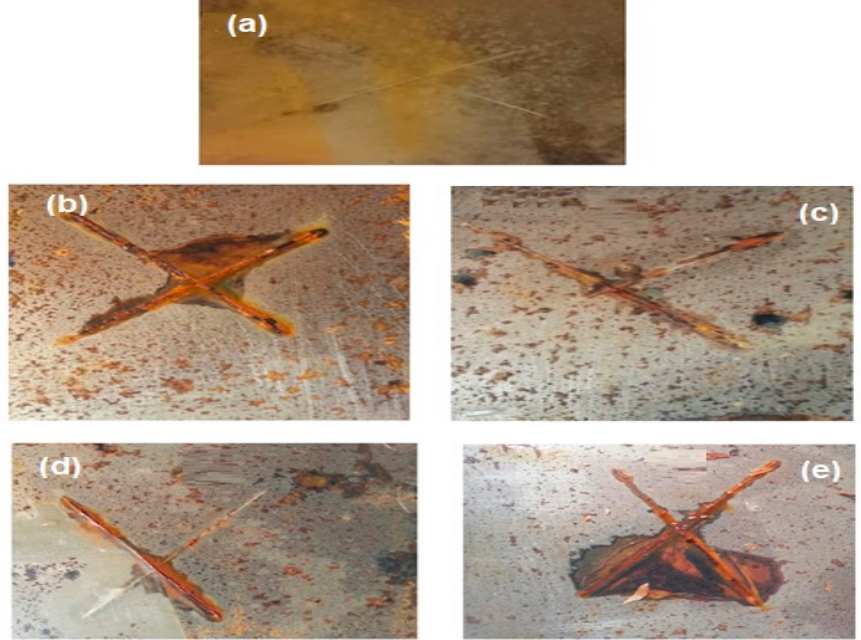
Figure 8. Salt spray resistance photos of epoxy coating mixed with different ( a ) 0, ( b ) 0.5, ( c ) 1.0, ( d ) 1.5, and ( e ) 2.5 wt.% of ZrO 2 /Cr 2 O 3 NPs coating films after 750 h of salt spray exposure. Table 3. Salt spray resistance of ZrO 2 /Cr 2 O 3 epoxy nanocomposites coating films at different ZrO 2 /Cr 2 O 3 NPs loading after exposure time 720 h.